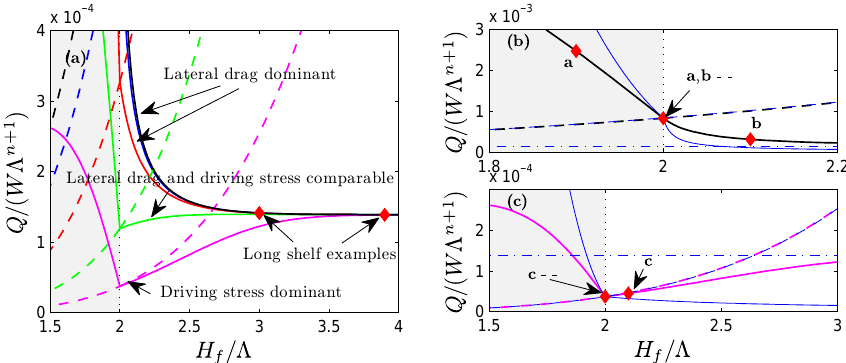
Figure 7. Limiting forms of ice flux near the critical ice thickness H f /(cid:51) = 2 and for large H f /(cid:51) . (a) A zoomed-in version of Fig. 5a, same colour scheme. The black, red and blue curves exhibit the anomalous relationship between flux and flotation thickness for a floating calving front, the green and magenta curves (with larger basal friction coefficients) do not. The “dominant stress” labels refer to terms in the force balance of the shelf that balance the depth-integrated extensional stress gradient (H(cid:54)) X for different basal drag coefficients (cid:48) ; see Sect. 5.3. Red markers correspond to profiles shown in Fig. 9. (b) Solution to the boundary layer problem for (cid:48)W (n + 1 )/n /(cid:51) = 0 plotted in black (same as in panel a ). Formula (12) is shown as a blue dashed line, formulae (16) and (20) as blue solid lines, while the dot-dashed blue line indicates the long shelf limit Eq. (24). Red markers correspond to the profiles shown in Fig. 8a and b. (c) Same as panel (b) but with the boundary layer solution for (cid:48)W (n + 1 )/n /(cid:51) = 125 shown in magenta and with red markers corresponding to profiles in Fig.